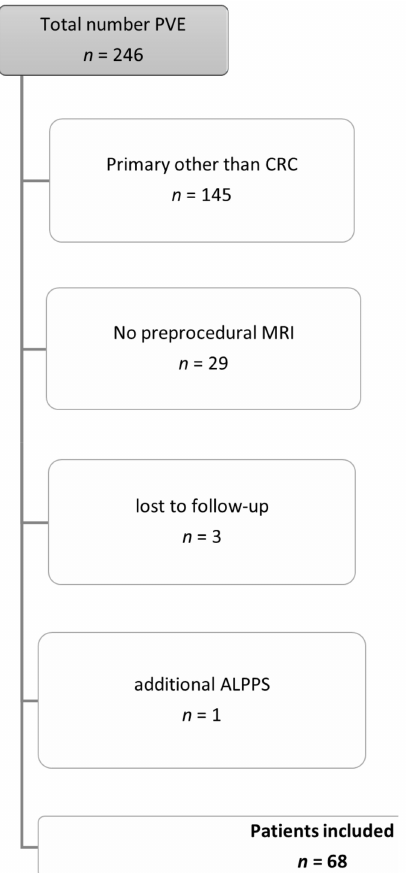
Figure 1. Inclusion and exclusion criteria for the patient cohort. Abbreviations: Portal vein emboliza- tion (PVE), colorectal cancer (CRC), magnetic resonance imaging (MRI), Associating Liver Partition with Portal Vein Ligation for Staged Hepatectomy (ALPPS).